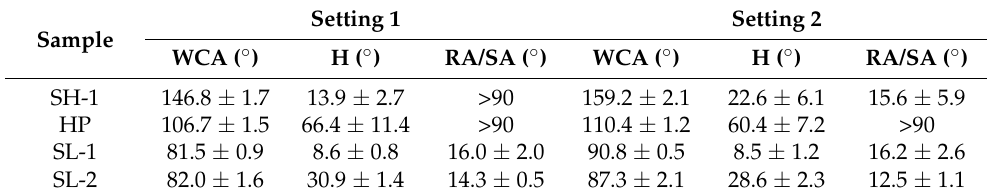
Table 2. Wettability at low temperature ( − 4 ◦ C) and standard deviation.